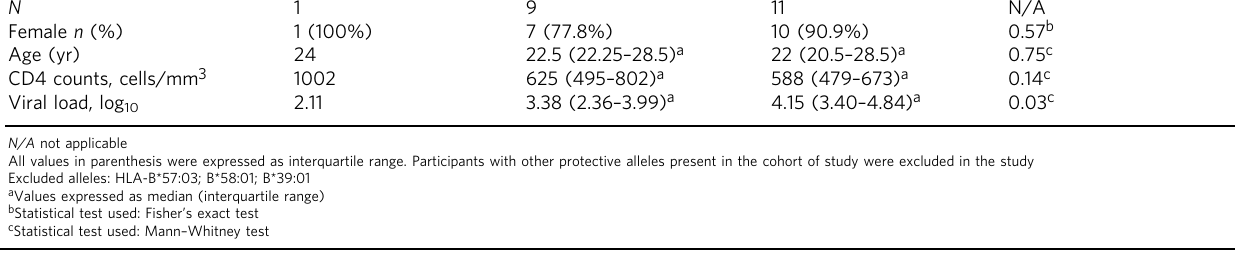
Table 1 Demographic and clinical characteristics of the study participants HLA